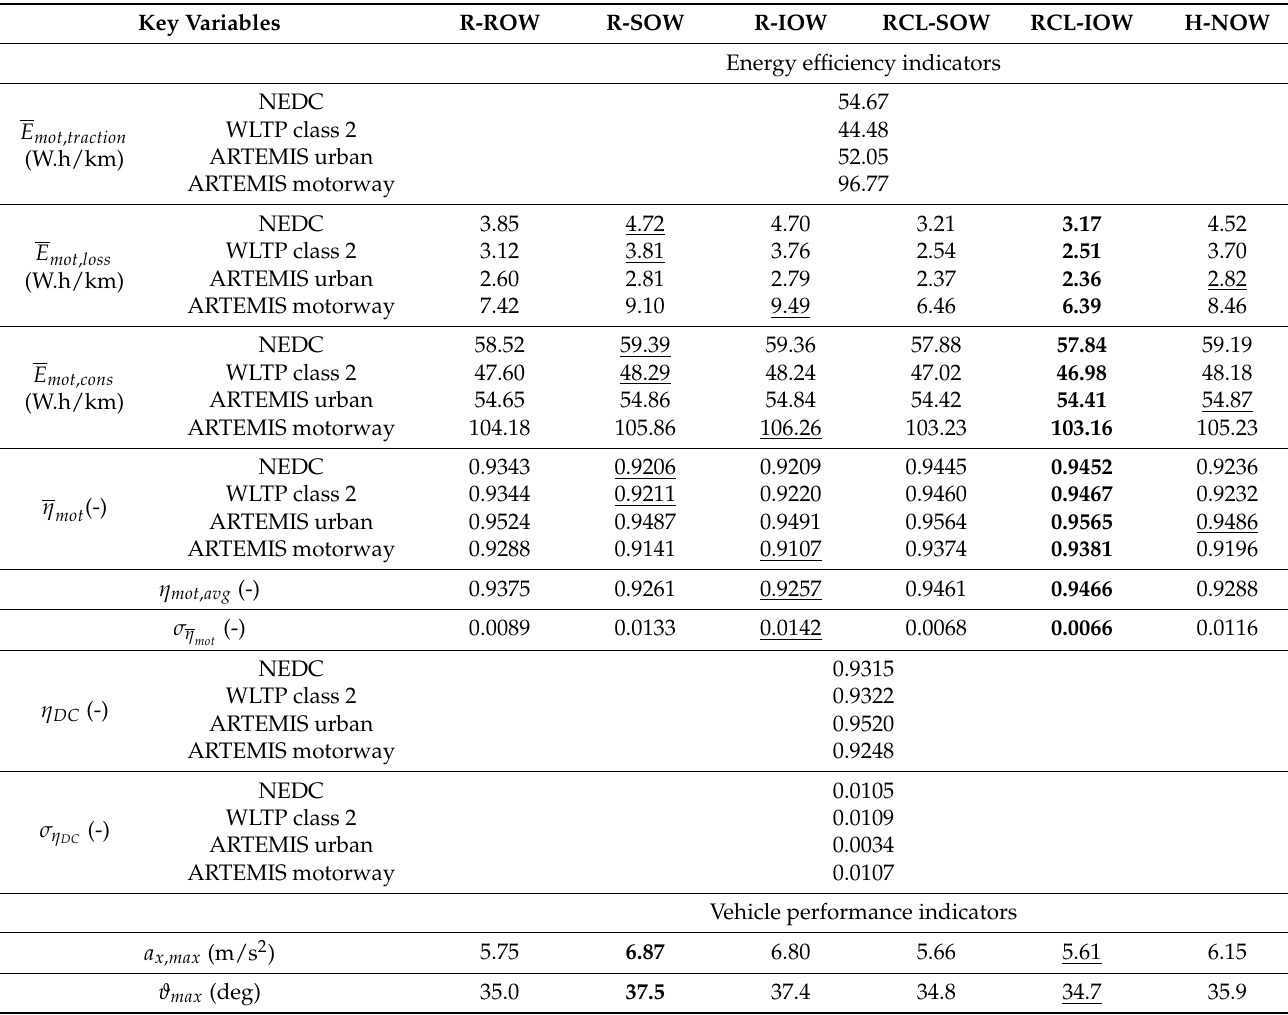
Table 7. Comparative summary of the performance of the case study EV with the considered IPMSM magnet arrangements. Key